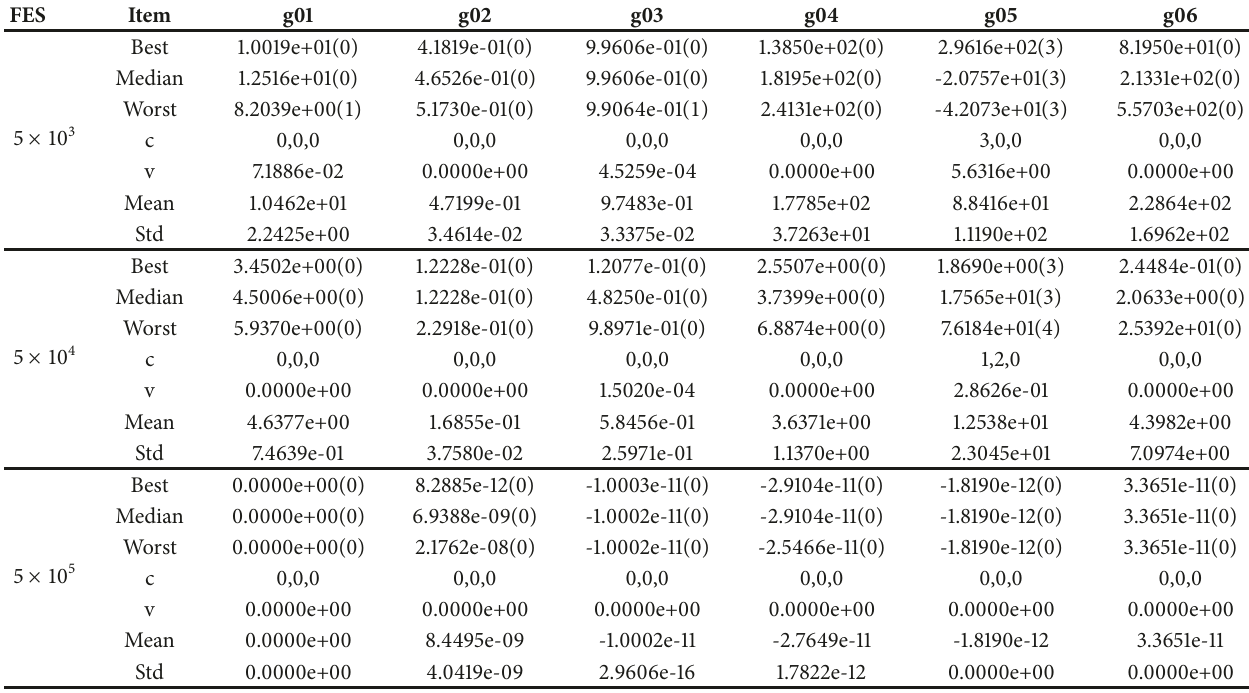
Table 2: General performance in terms of function error values achieved by CADE for test functions g01-g06. FES